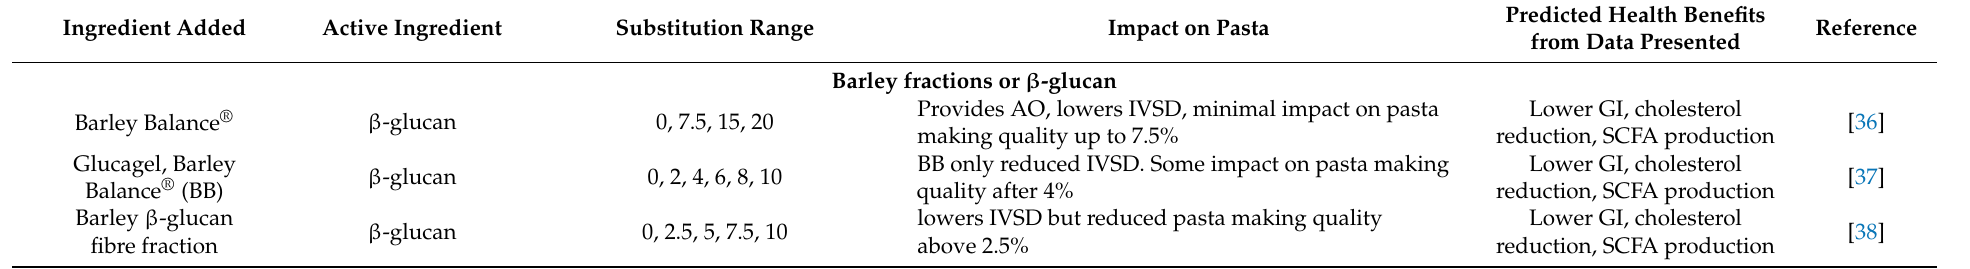
Table 2. Examples of pasta made with a combination of semolina and non-traditional